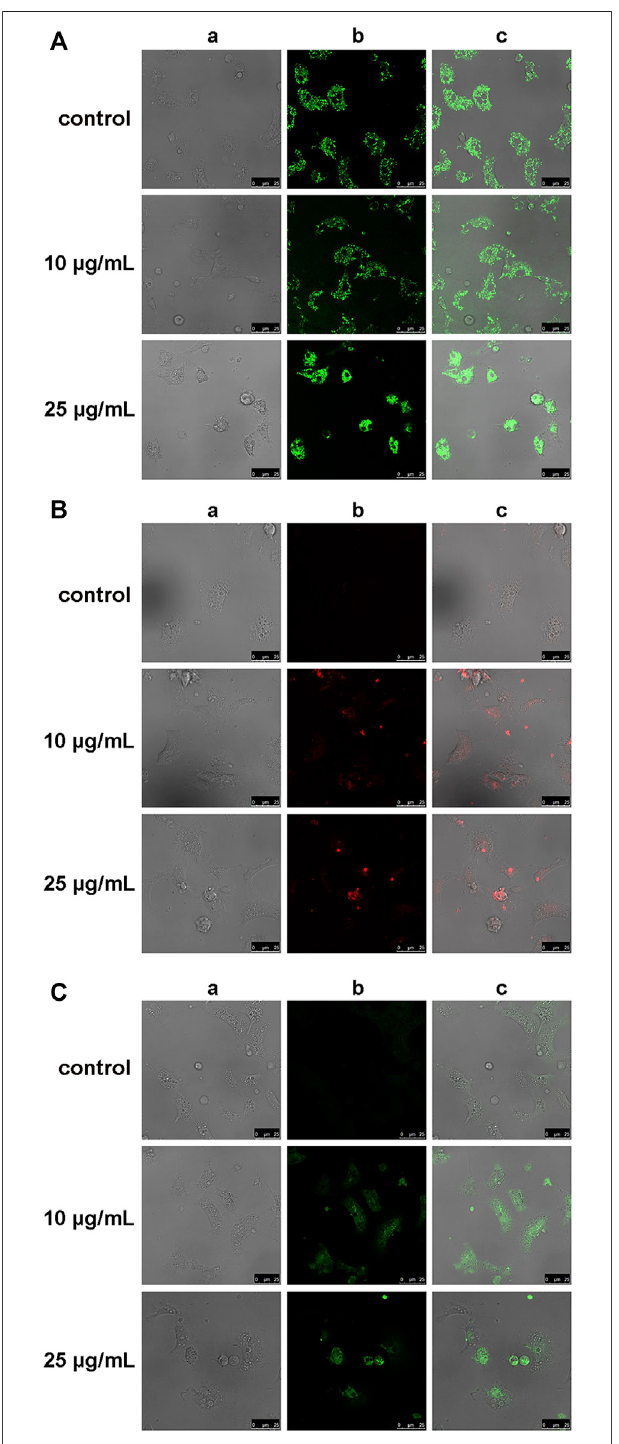
FIGURE 8 | Effects of the OlyA6/PlyB mixture on mitochondrial and oxidative stress parameters in M. galloprovincialis hemocytes evaluated by confocal laser scanning microscopy. Representative images of hemocytes exposed to different concentrations of the OlyA6/PlyB mixture at the OlyA6/PlyBmolarratio12.5/1andloadedwith (A) tetramethylrhodamineethyl ester (TMRE), for mitochondrial membrane potential; (B) MitoSOX Red for